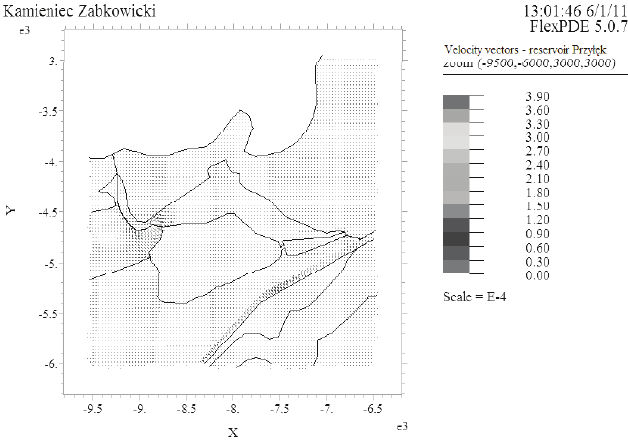
Fig. 13. Velocity vectors in the area of recreational reservoir Przyłęk